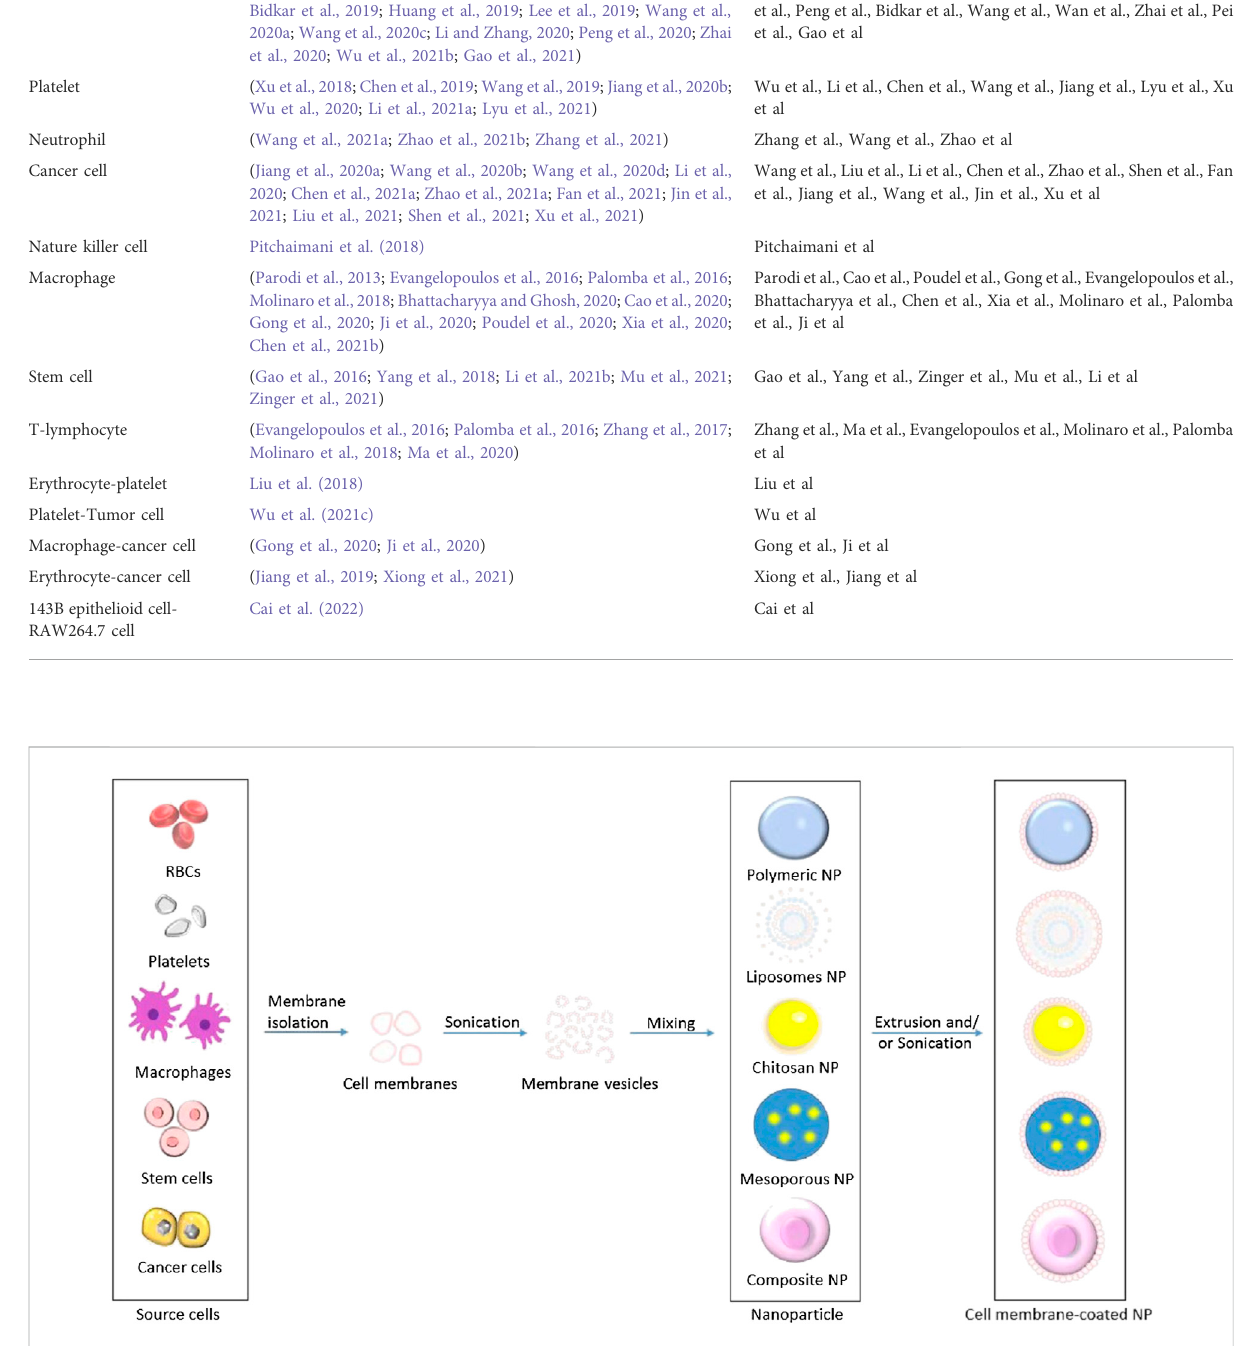
FIGURE 2 Schematic illustration of processes of isolating cell membranes and making cell membrane vesicles from different source cells for camou fl aging different core nanoparticles.